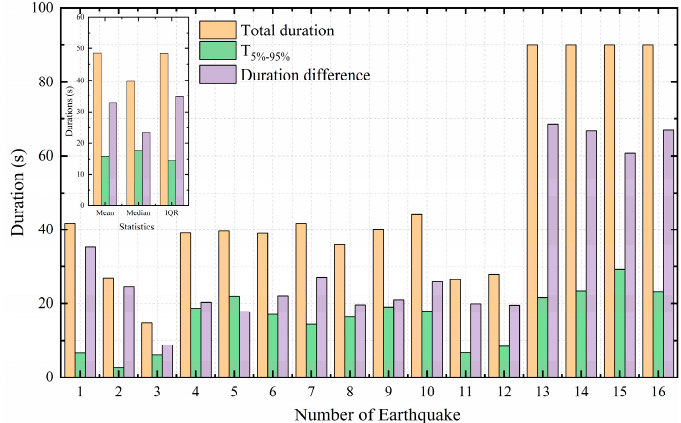
Figure 13. The comparison of the results for all reduced duration and total duration.